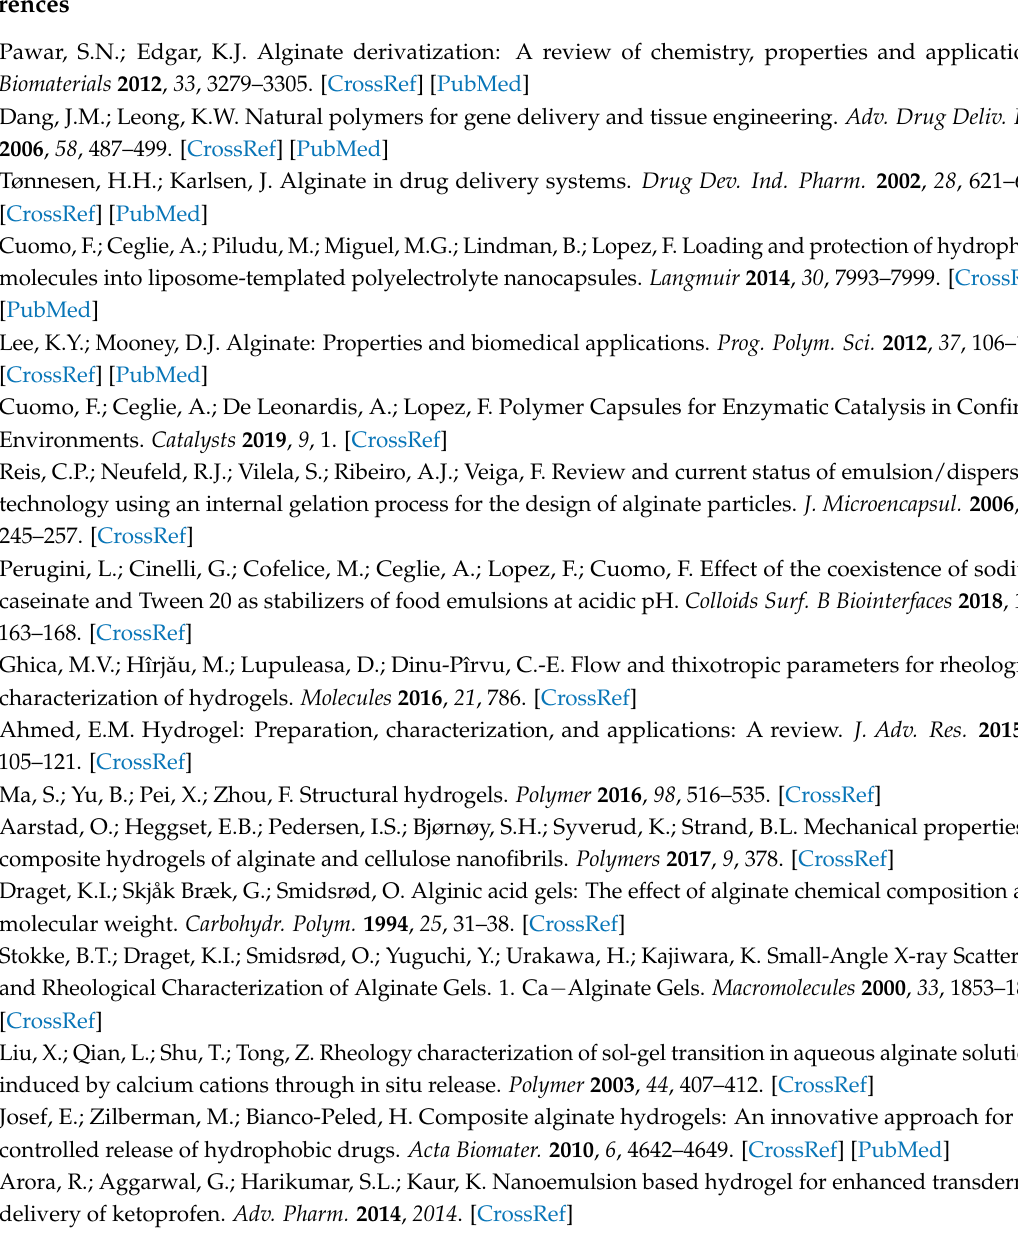
Figure S1: Calibration curve pH vs